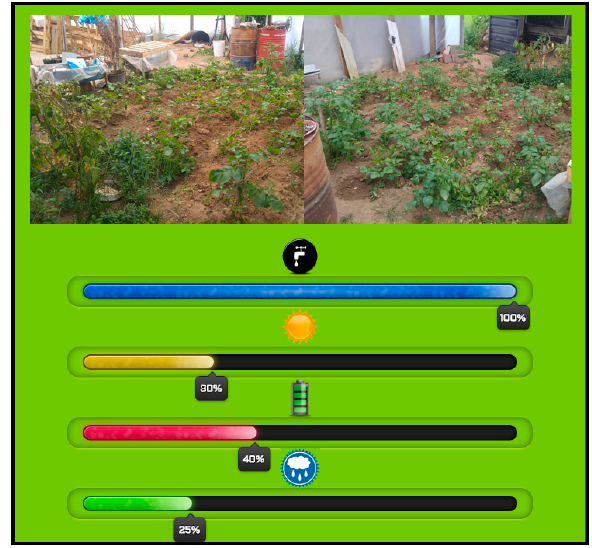
Figure 20. User interface screen capture with information from the different sensors displayed on the TV platform.